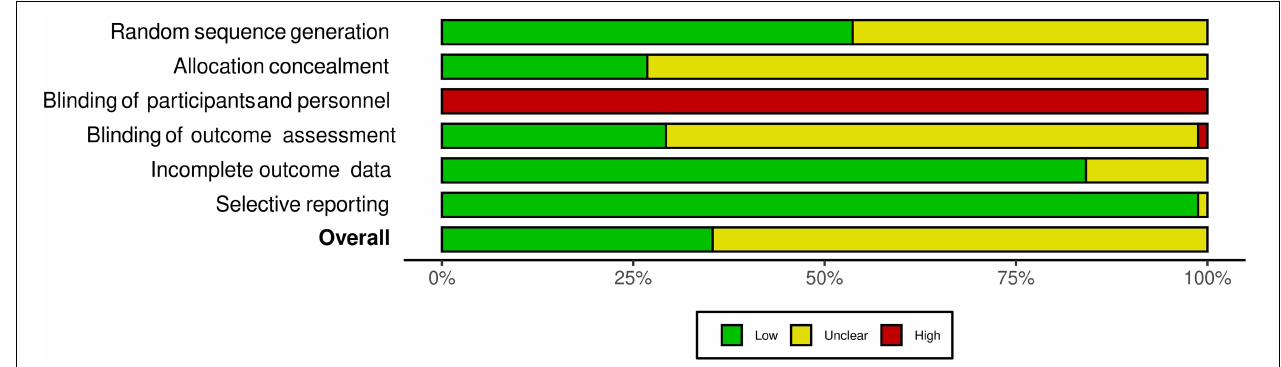
FIGURE 3 | Summary of risk of bias. Summary of risk of bias based on each criterion measured by the Cochrane Risk of Bias tool. Graphic by the RoB2 tool.